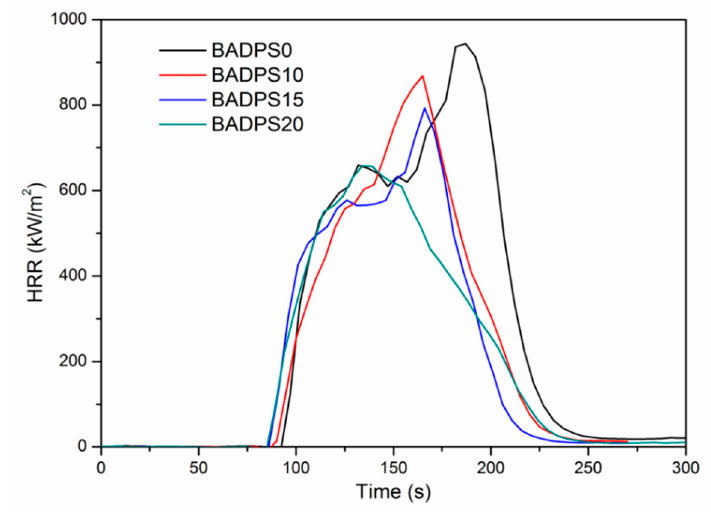
Figure 7. Heat release rate (HRR) curves of the different UPRs.